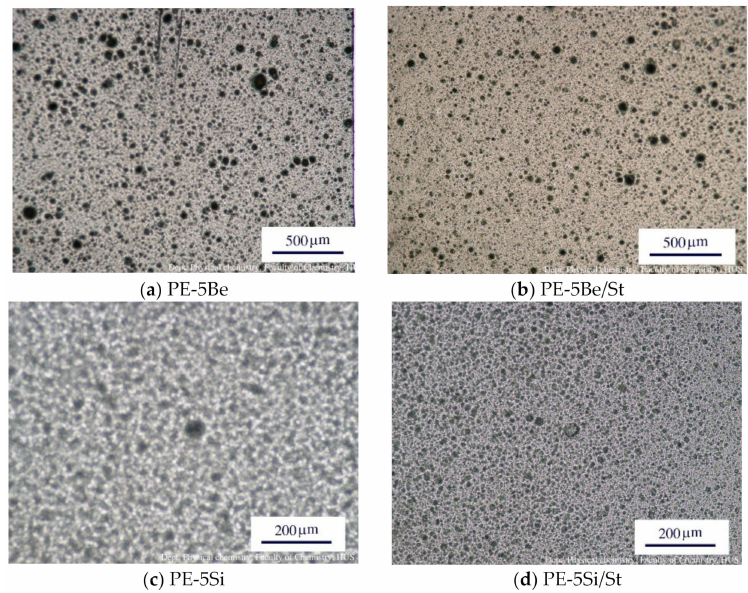
Figure 6. Optical micrographs of bentonite and silica filled LLDPE